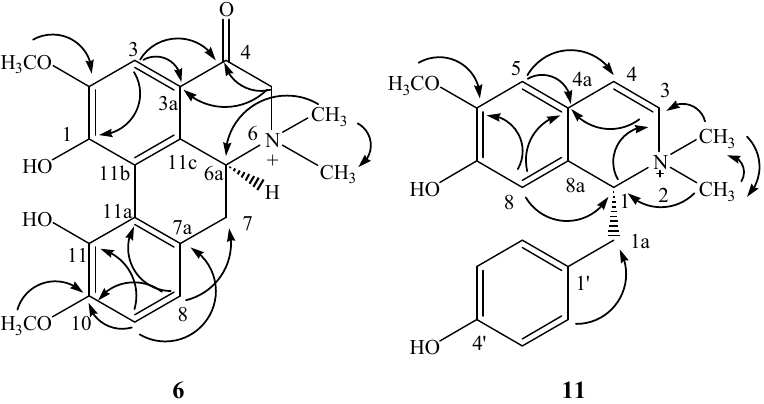
Figure 2. Key HMBC correlations of compounds 6 and 11